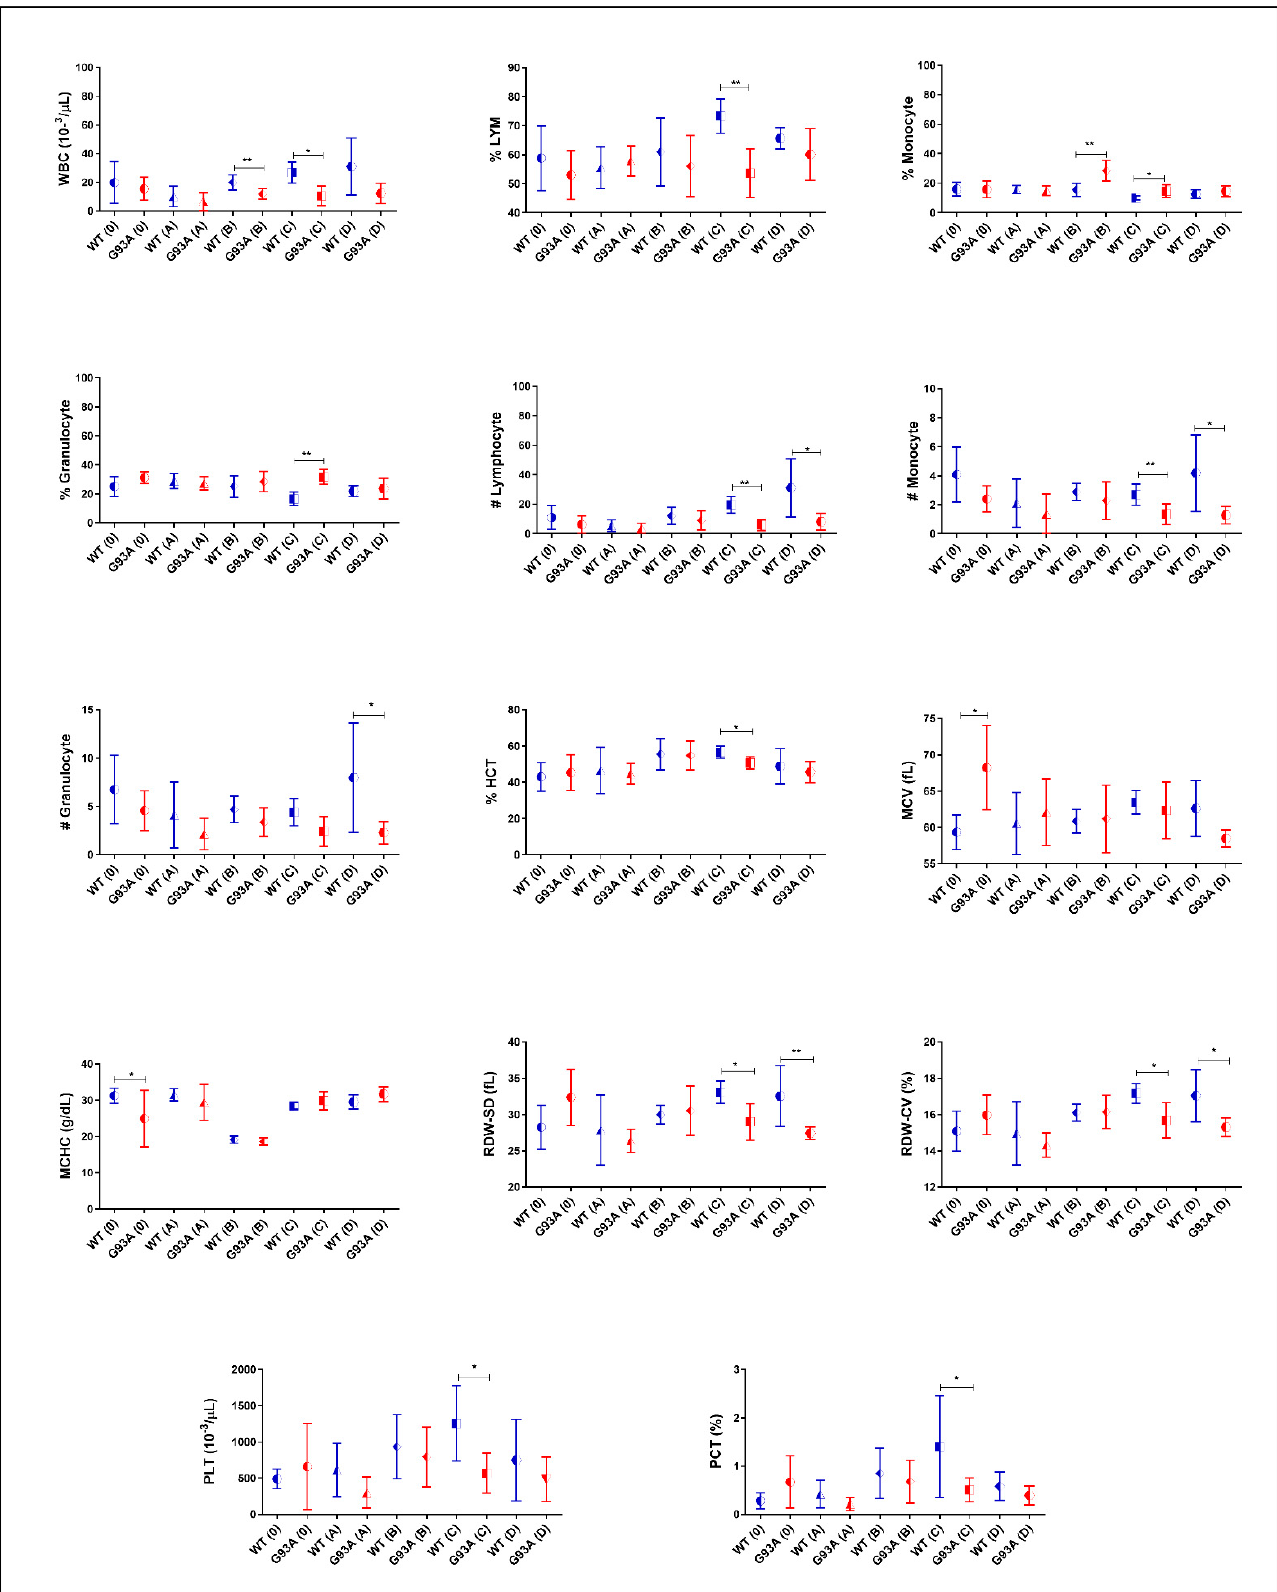
Figure 4. Blood parameters of the SOD1 G93A and SOD1 WT rats. All results were given as mean ± SD of n = 6–8 animals for each group. Notes: * p ≤ 0.05, ** p ≤ 0.01.